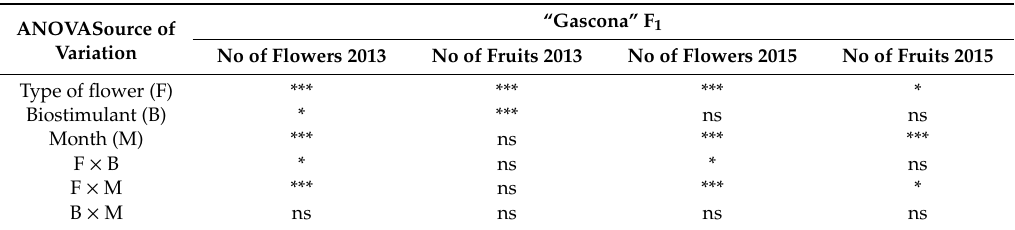
Table 5. Results of ANOVA for parameters of flowering and fruit setting of “Gascona” F 1 eggplant presented in Figure